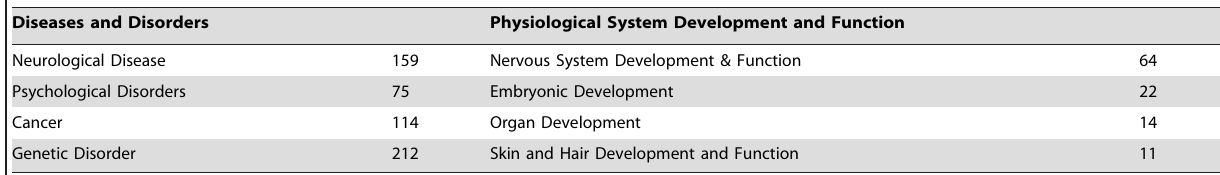
Genetic Disorder 212 Skin and Hair Development and Function Pathway analysis showing the four most significant diseases and disorders linked (left columns) and physiological systems (right columns) altered in the brains of MAM- treated vs. vehicle-treated Mgmt 2 / 2 mice plus Mgmt 2 / 2 vs. wt mice treated with respect to MAM vs. vehicle. Data were aggregated and all time points were combined for a total of 443 molecules.